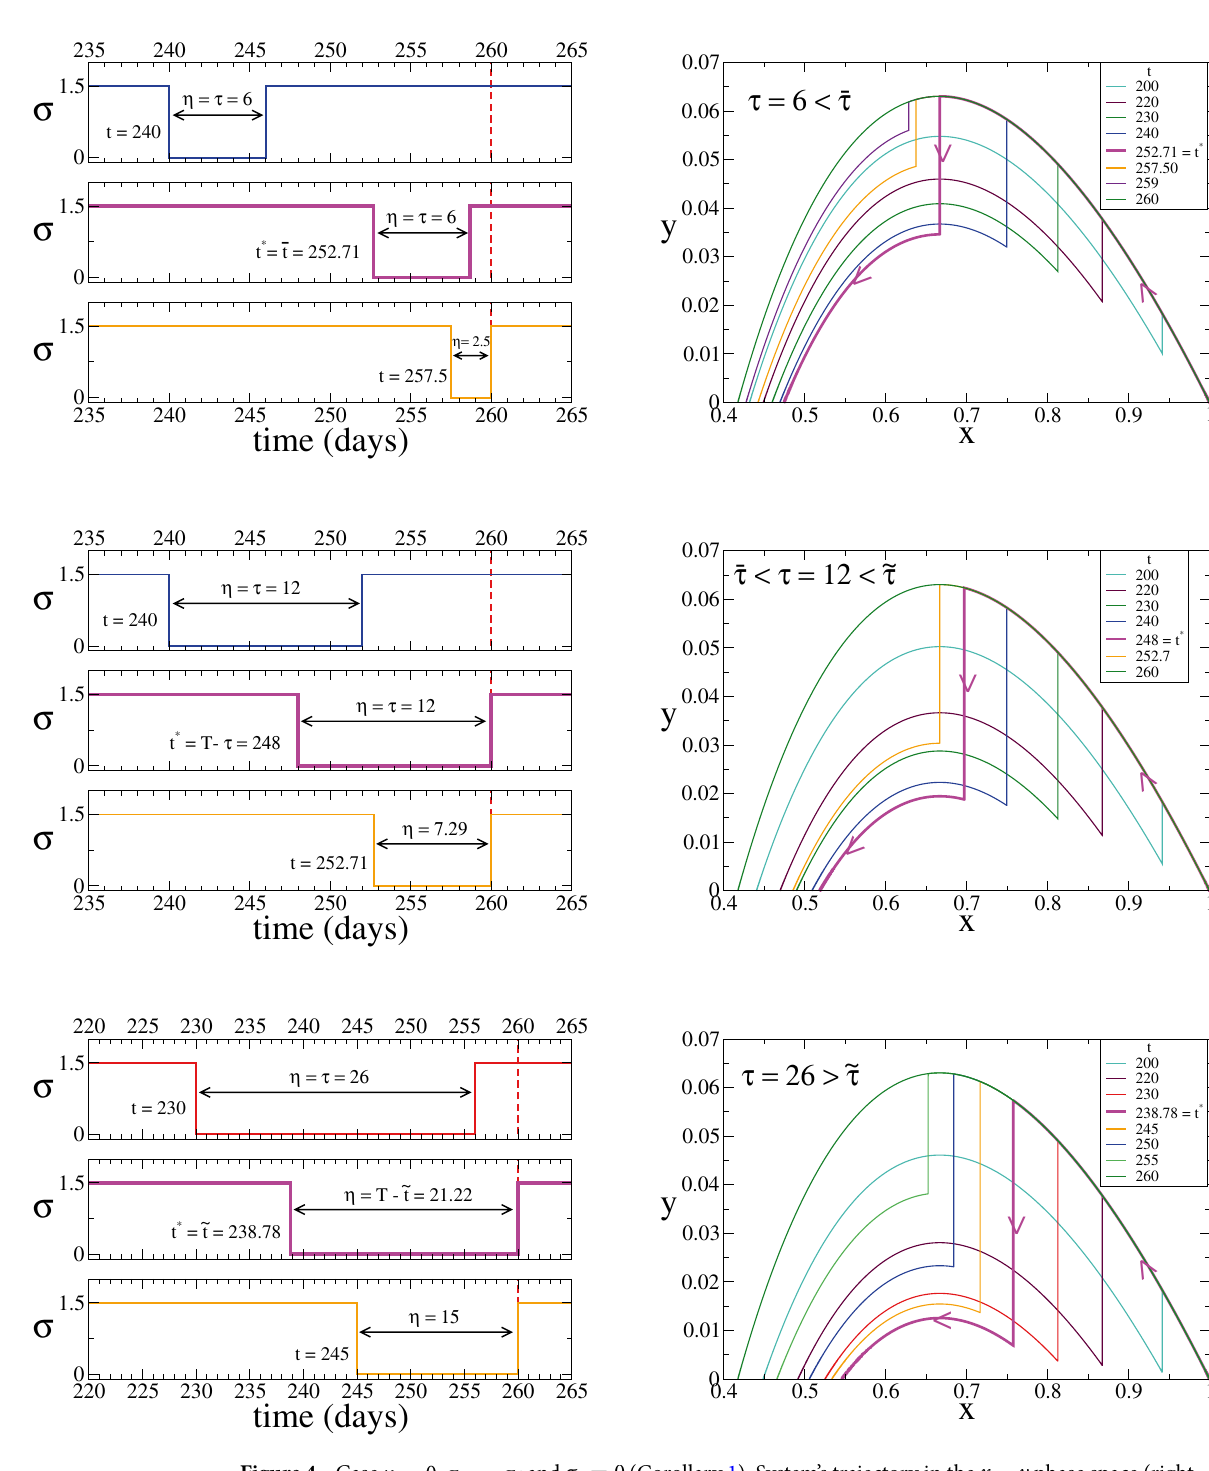
Figure 4. Case κ = 0 , σ m = σ f and σ s = 0 (Corollary 1). System’s trajectory in the x − y phase space (right panels), for γ = 0.1 , κ = 0 , σ m = σ f = 1.5 , σ s = 0 and T = 260 , and the three values of τ indicated in the legends corresponding to the different regimes of the optimum time t ∗ (pink lines). Left panels show the time evolution of σ for three different initial times t of the strict quarantine in each case. The optimum times are t ∗ = t ≃ 252.71 for τ = 6 (top panels), t ∗ = T − τ = 248 for τ = 12 (middle panels) and t ∗ = ˜ t ≃ 238.78 for τ = 26 (bottom